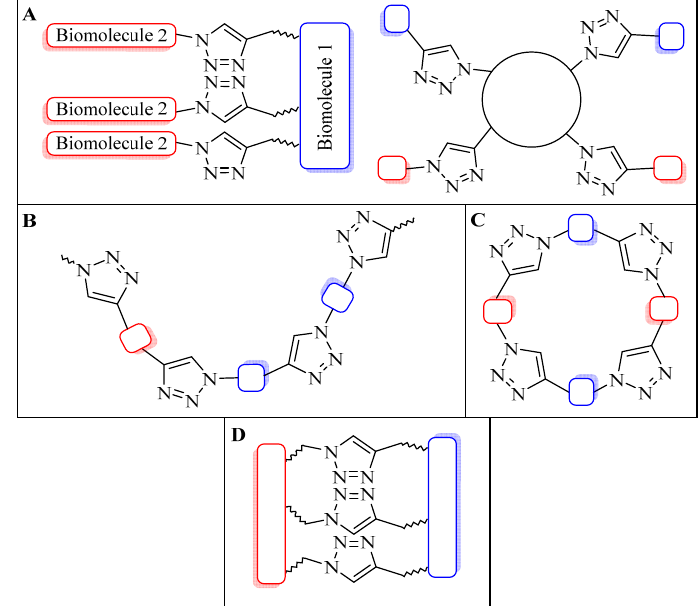
Figure 7. Multiple conjugation strategy using CuAAC approach; ( A ) dendritic, ( B ) linear, ( C ) cyclic, ( D ) cross-linked.